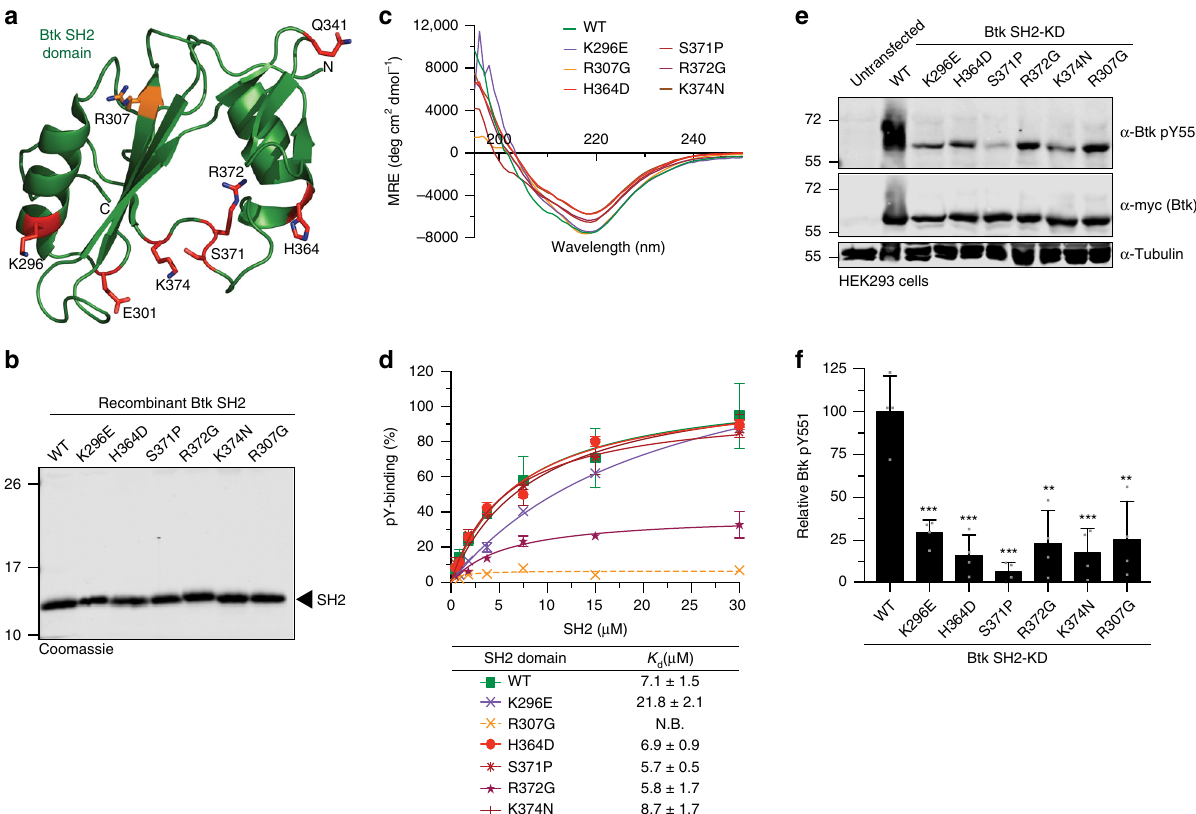
Fig. 1 Mutations in Btk SH2 domain abrogates pY551 phosphorylation. a Mapping of a subset of XLA-patient mutations (red sticks) onto the human Btk SH2 domain structure (PDB 2GE9). The residue R307 (orange sticks) is part of the pY-binding motif (FIVRD). Here and in all subsequent fi gures, the residue numbering refers to full-length human Btk. b Representative SDS-PAGE analysis of recombinant wild-type and mutant Btk SH2 domains puri fi ed from E. coli . c Averaged far-UV circular dichroism (CD) spectra of recombinant wild-type and XLA mutant Btk SH2 domains. Mean residue ellipticity (MRE) for each protein was calculated from three independent measurements. d Binding of a fl uorescently labeled pY-peptide to recombinant Btk SH2 domains. Indicated K d values were obtained from the fi tting to a 1:1 binding model. Data are mean ± SD of two technical replicates. Non-binding (N.B). e HEK293 cells were transiently transfected with a construct containing an N-terminal 6xMyc-tagged human Btk SH2-KD wild-type or mutants. Immunoblotting of cell lysates was performed to assess Btk pY551 phosphorylation. f Quanti fi cation of pY551 immunoblot shown in e and normalized to total Btk (Myc) expression. Data are mean ± SD of three biological replicates ( n = 4) and P -values were calculated using an unpaired t -test. ** P ≤ 0.01 and *** P ≤ 0.001. Source data are provided as a Source Data fi